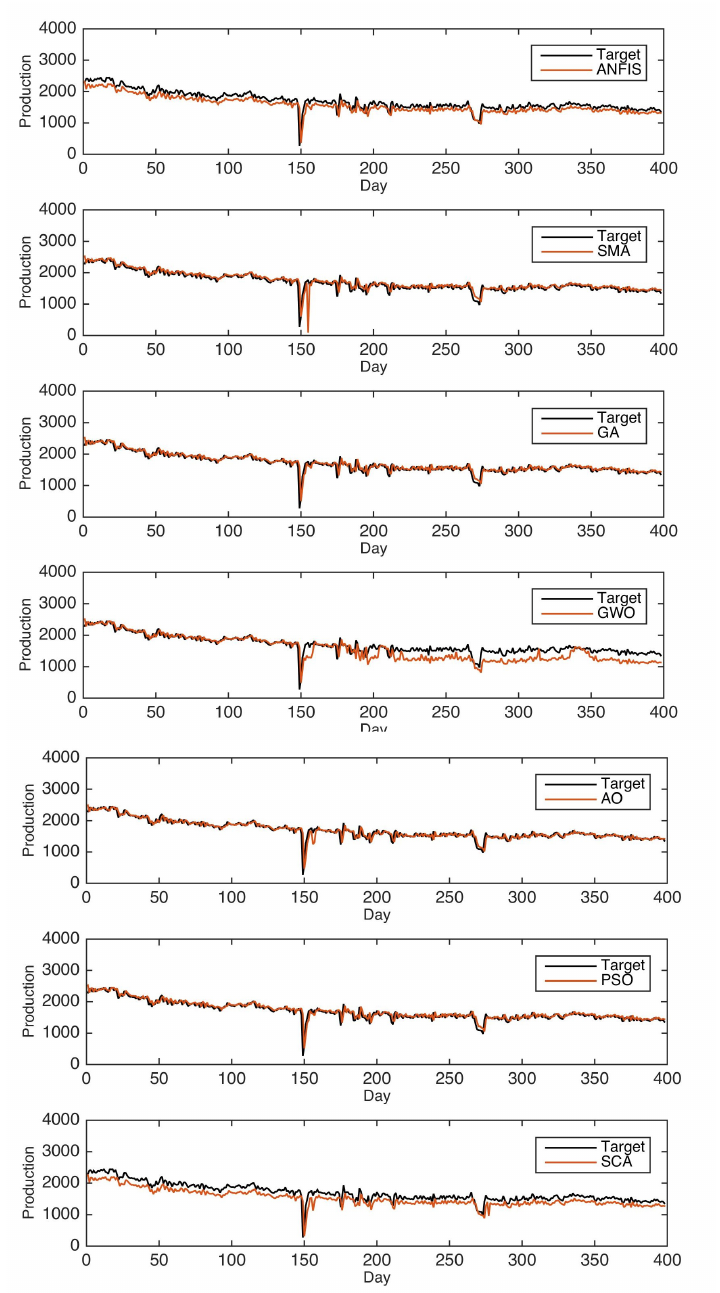
Figure 5. The results of the AO and the compared models for the Masila